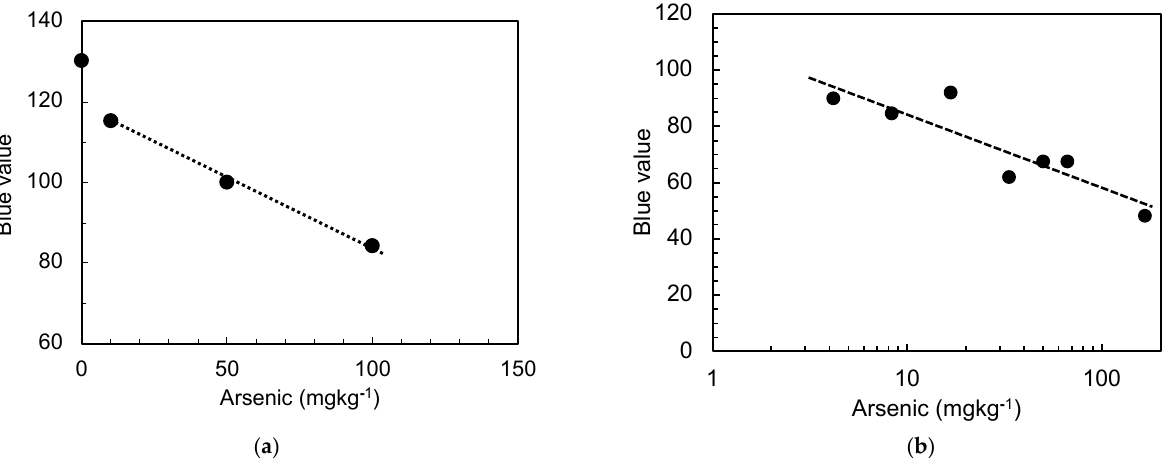
Figure 6. Arsenic levels in arsenic-containing gypsum, as determined using the proposed method, using the test kits for ( a ) high; ( b ) low arsenic contents.